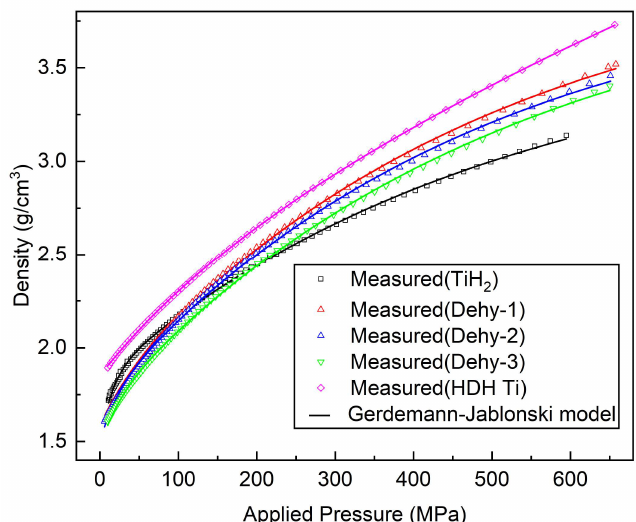
Figure 9. TiH 2 , Dehy-1, Dehy-2, Dehy-3 and HDH Ti powders compaction data fitted according to Equation (3). Table 5. Fit Parameters to Equation (3) for the Powder Materials Under Investigation.